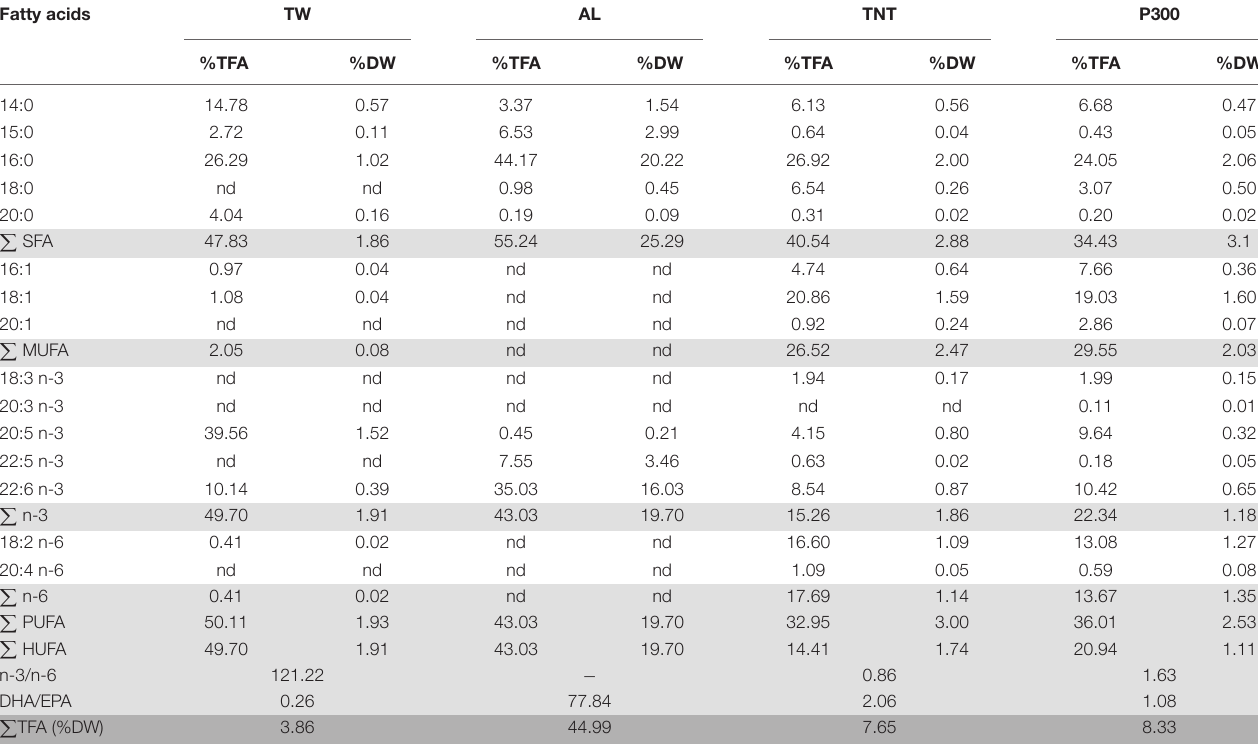
TABLE 2 | Fatty acid composition of the feed analyzed by